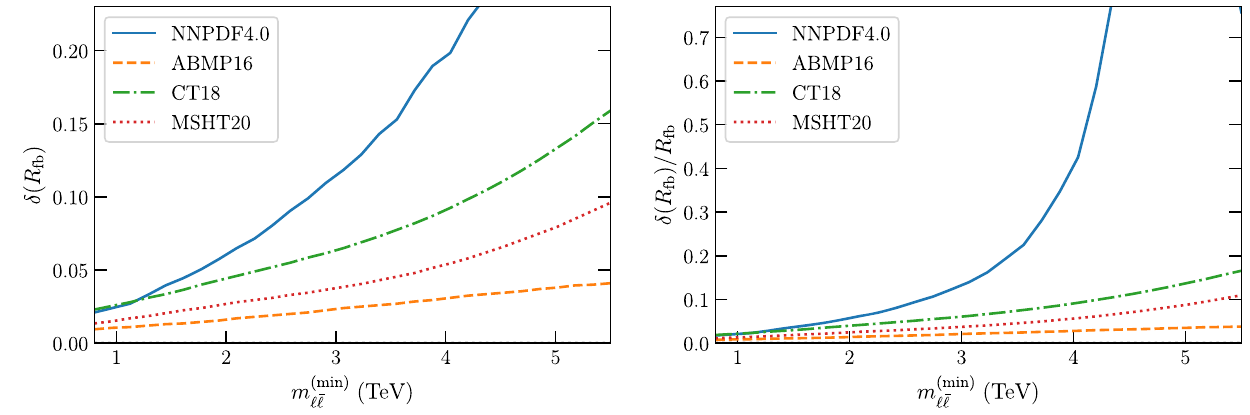
Fig. 16 The absolute (left) and relative (right panel) uncertainties in the coupling ratio R fb shown in Fig. 15.